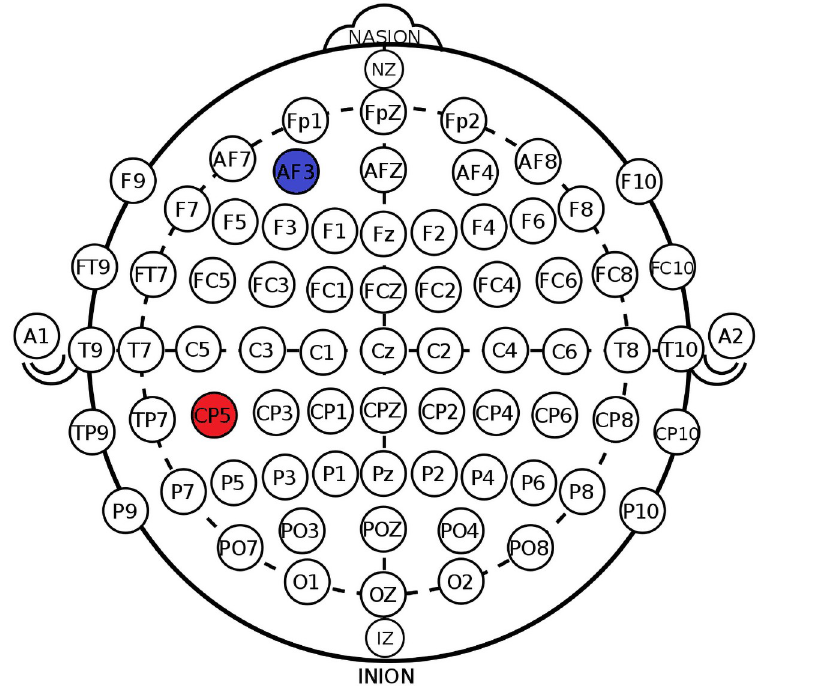
Fig 1. tDCS electrode placement with the cathode over AF3, the anode over